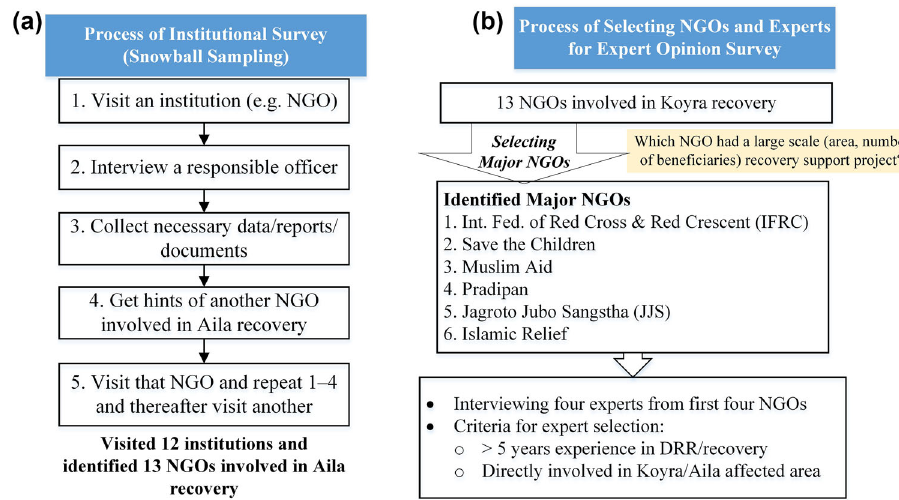
Fig. 2 Process of institutional surveys and expert